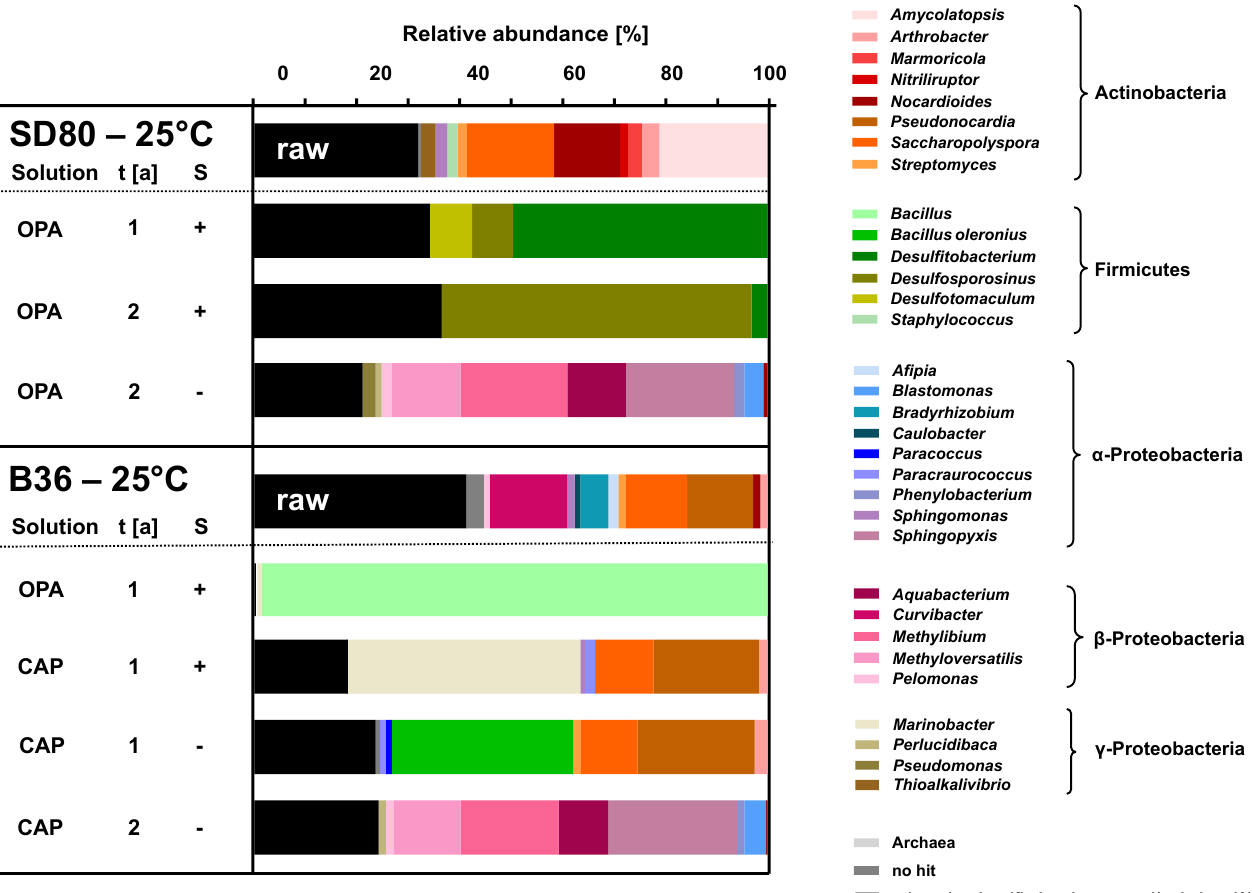
Figure 4. Microbial diversity in B36 and SD80 raw materials and samples incubated at 25 ◦ C. Shown is the relative abundance of detected genera and their dependence on the added substrates (+S) and incubation time (t in years). The microbial community was analyzed by amplifying and sequencing the V4-region of the 16S rRNA gene via MiSeq Illumina (modified from Matschiavelli et al.